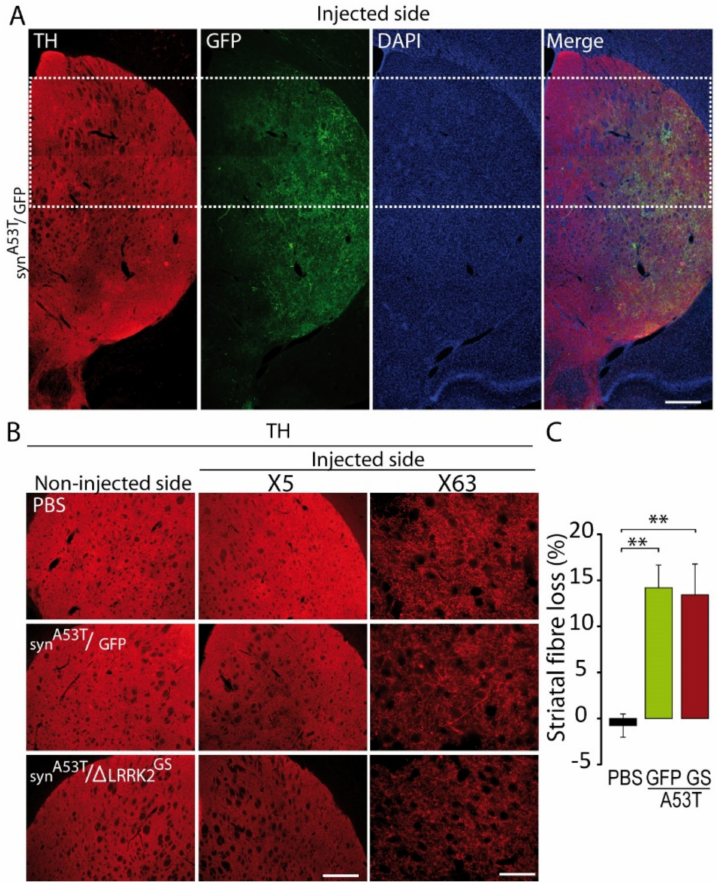
Figure 6. Tyrosine hydroxylase (TH) levels in the striatum of rats injected with AAV- α -syn A53T with AAV-GFP or ∆ LRRK2 G2019S in the right SNpc. ( A ) Photomicrographs at low magnification showing immunofluorescence for TH (red) and GFP (green) in the striatum at 15 weeks PI. Scale bar: 1000 µ m. ( B ) Photomicrographs at two different magnifications (5 × and 63 × ) showing TH-related immunofluorescence in the striatum of rats injected with PBS or AAV- α -syn A53T with AAV-GFP, as a control, or ∆ LRRK2 G2019S (GS). Scale bar in B: 5 × , 1000 µ m, 63 × , 100 µ m. ( C ) Quantification of fluorescence in the striatum. Quantification was performed at 5 × magnification. Results are expressed as the means ± SEM. N = 10 animals/group. ANOVA and PLSD post hoc test. ** p <